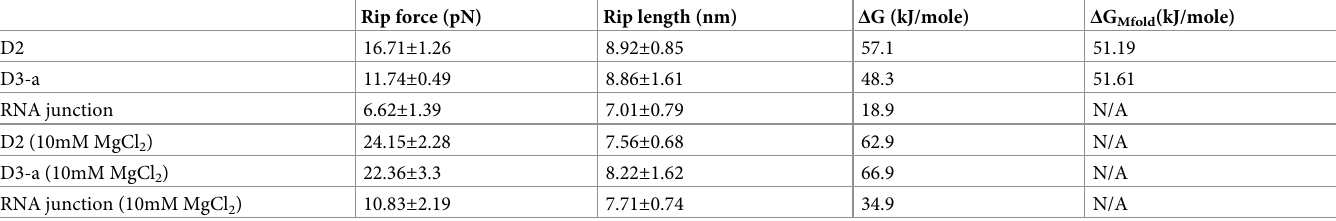
Table 2. Free energy of RNA